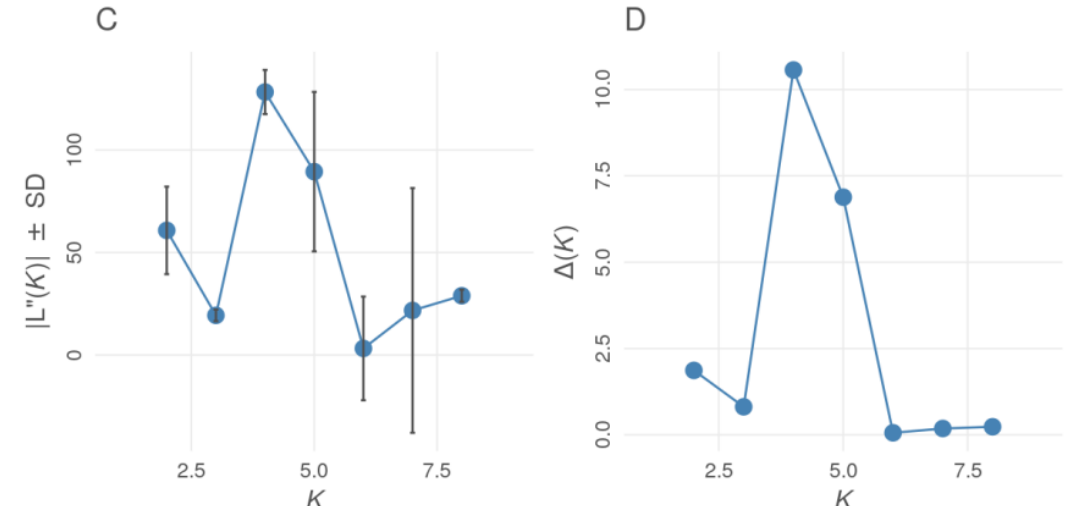
Figure 3. Presentation of the graphical method of identifying the true K value ( A ) Mean L (K) ( ± SD) of 15 runs for each K value. ( B ) Rate of change of the likelihood distribution calculated from the formula L ′ (K) = L (K)-L (K-1). ( C ) Second-order absolute values for the rate of change of the likelihood distribution, calculated from the formula | L ′ ′ (K) | = | L ′ (K + 1)-L ′ (K) |. ( D ) ∆ K calculated from the formula ∆ K = m | L ′ ′ (K) | / s [L (K)]. The absolute value of the peak of this distribution is the true K [17].